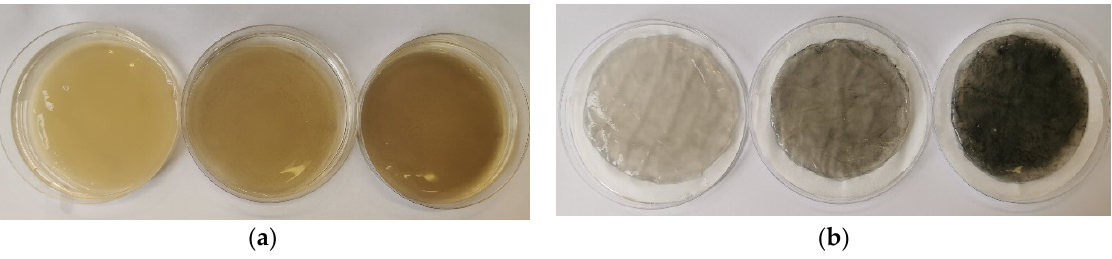
Figure 3. Examples of GO/BC nanocomposite samples with 10 ppm, 25 ppm, and 50 ppm (from left to right) GO concentration, before ( a ) and after ( b ) the neutralization process in 0.5 M NaOH.